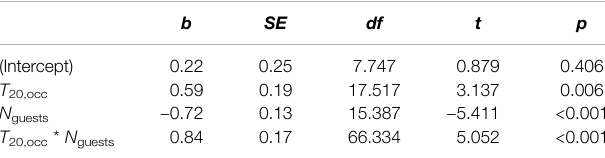
TABLE 2 | Results of the Principal component analysis – Varimax-rotated factor loadings of the non-acoustical restaurant quality items on the observed three underlying dimensions.